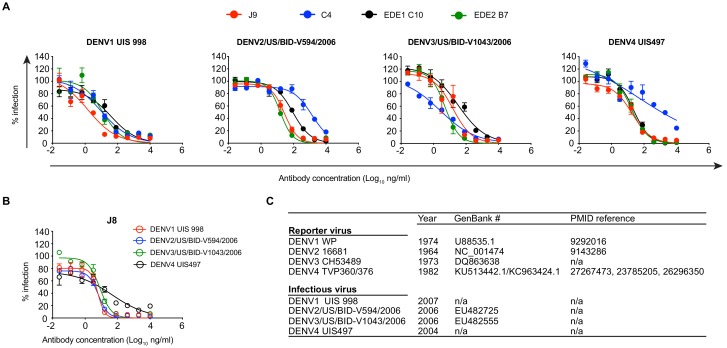
Neutralization potency of antibodies against fully infectious DENV1-4 strains.Neutralization of fully infectious DENV1-4 strains by (A) J9, C4, EDE1 C10, EDE2 B7, and (B) J8 was determined by intracellular staining with AF488-conjugated anti-E protein 4G2 antibody at 48 hr post-infection. Error bars indicate the range of duplicate infections. Infectivity levels were normalized to those in the absence of antibody. Dose-response neutralization curves represent one experiment. (C) Comparison of fully infectious DENV strains used in (A) and (B) to DENV reporter viruses used in our study. For each virus, the year of isolation is listed, as well as the GenBank Accession number and PMID reference, if available. The nucleotide sequence of the structural genes (C, prM, E) used to make DENV4 TVP-360 (GenBank # KU513442.1) reporter virus is identical to that of DENV4 TVP-376 (GenBank # KC963424.1) with the exception of a silent mutation in the stem region of the E protein.